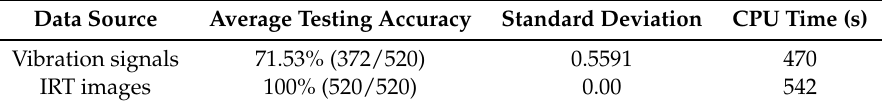
Table 4. Diagnosis results for Scenario 1 using IRT–CNN and Vib-CNN methods.